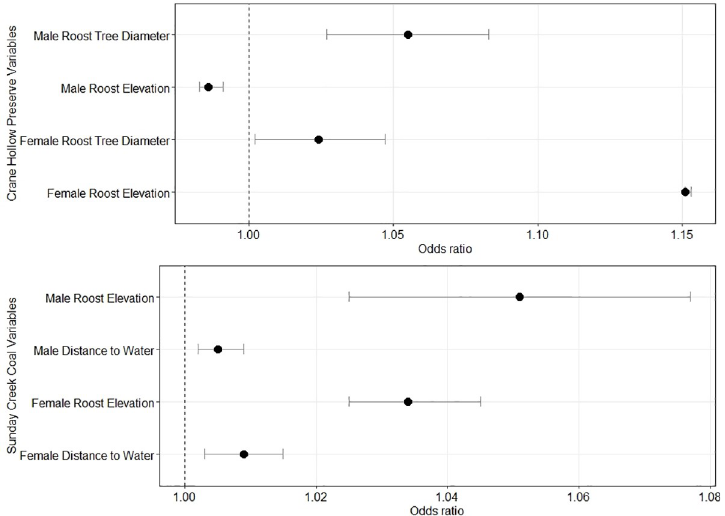
Fig 1. Forest plot representing the odds ratios for each variable included in top models for male and female eastern red bats at Crane Hollow Preserve (top panel) and Sunday Creek Coal (bottom panel) study areas in southeast